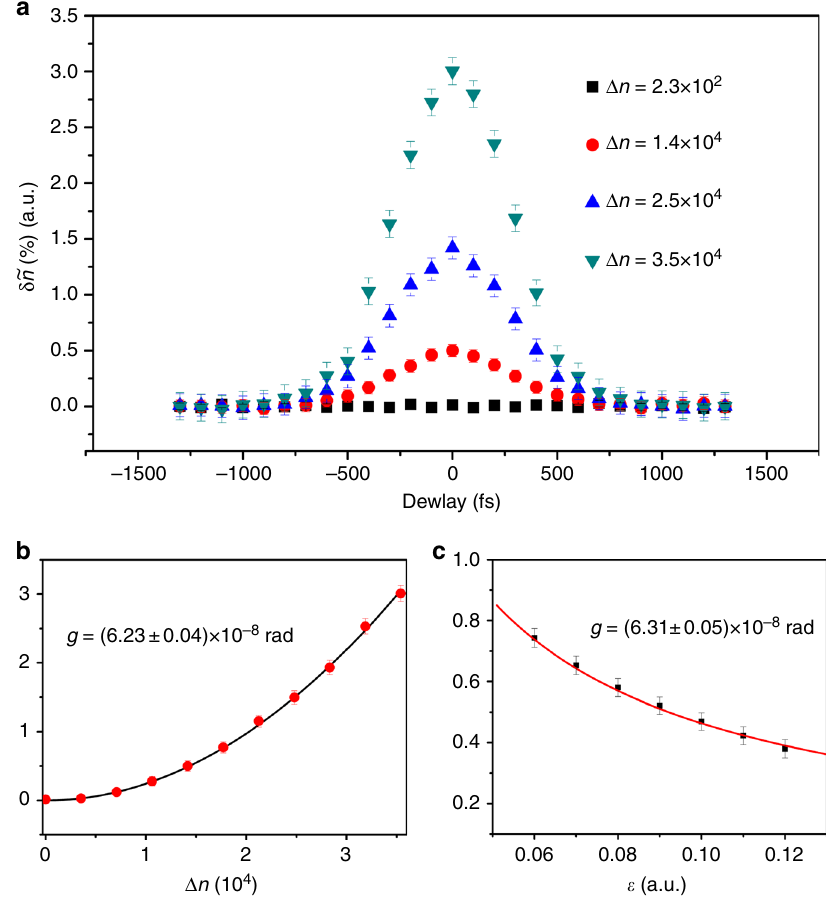
Fig. 3 Demonstration of the validity of Eq. (5). All plots show the normalized change in the average photon number δ ~ n with N = 5 × 10 4 . a A delay in the probe controls the temporal overlap with the system inside the PCF and thus tunes the interaction strength (here with ε = 0.1). This is performed for several magnitudes of modulation, and the results trace out Gaussian shape for non-zero modulation amplitude. However, in the absence of modulation, ffiffiffiffi p ’ 10 2 is too small to observe the effect of the interaction. b The standard deviation Δ n is changed the standard deviation due to the shot noise Δ n ¼ N by controlling the magnitude of the modulation in the intensity of the probe, with ε = 0.1. c Tuning the post-selection parameter ε , while Δ n = 1.4 × 10 4 . The results in both ( b , and c ) are fi tted to Eq. 5, and an estimate of g , with an error due to the fi tting quality, is shown in each panel. The error bars are shown as ffiffiffi p ν the uncertainty in δ ~ n , which is written as σ = . Here, σ is the standard deviation of measured δ ~ n and ν is number of recorded probe pulses by